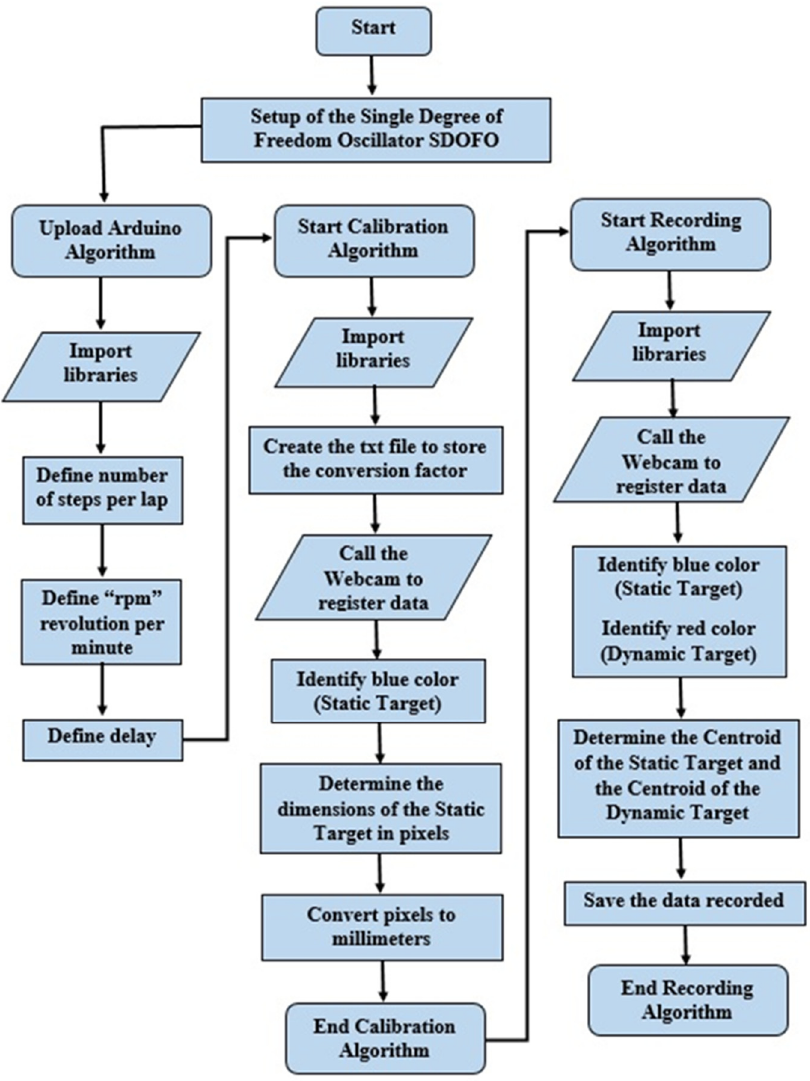
Figure 8. Required Arduino codification to guarantee and record an oscillatory movement. The calibration algorithm generates the conversion factor between pixels and millimeters, and the recording algorithm registers the required data to find the displacements and times in each video frame.